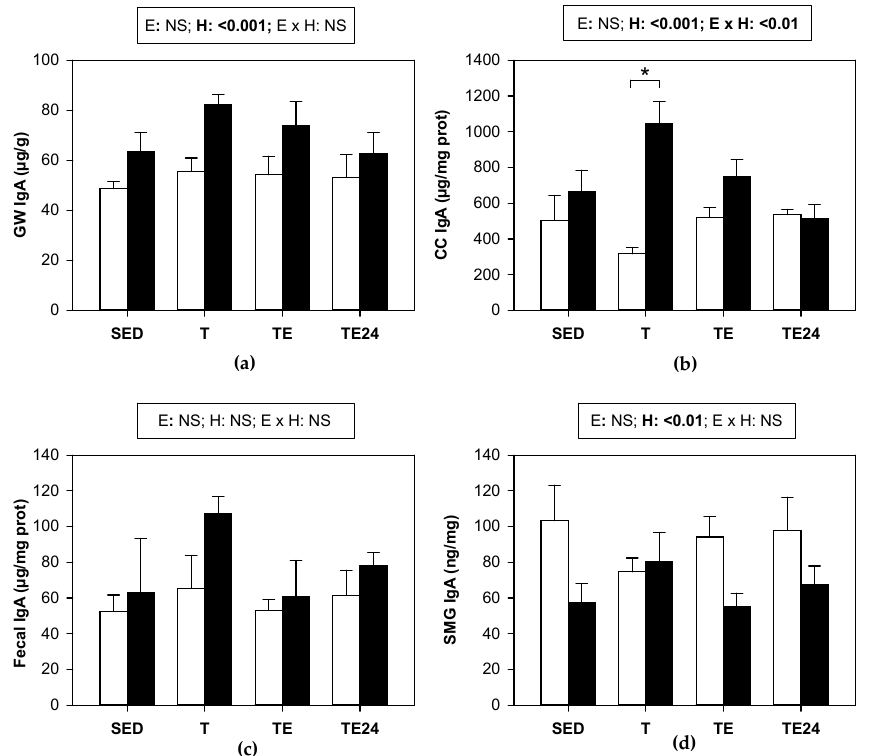
Figure 7. IgA concentration in: ( a ) gut wash; ( b ) cecal content; ( c ) fecal homogenate; ( d ) submaxillary glands. The non-supplemented groups are represented by white bars and the hesperidin-supplemented groups by black bars. GW = gut wash; CC = cecal content; SMG = submaxillary glands; SED = sedentary groups; T = trained groups; TE = T groups with an additional exhaustion test; TE24 = TE groups 24 h after the exhaustion test; E = exercise; H: hesperidin supplementation; E × H = interaction between E and H; NS = no significant differences. Data are expressed as mean ± SEM ( n = 8). Statistical analysis (ART-ANOVA test): global effect of hesperidin supplementation is indicated in the corresponding box above. When E × H interaction was significant, an emmeans post hoc test (Tukey-adjusted p value for non-parametric data) was carried out, changes due to hesperidin supplementation are represented with an asterisk.